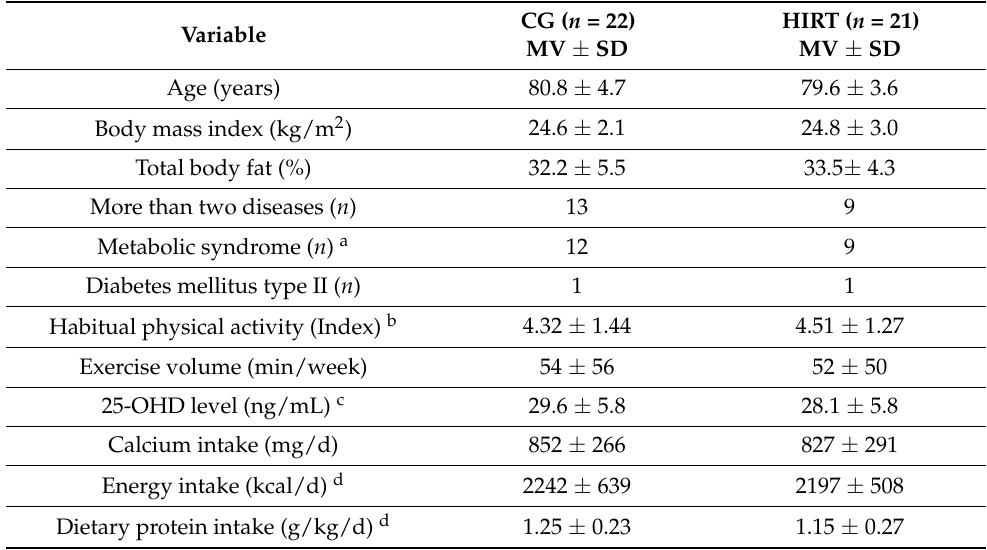
Table 1. Baseline characteristics (i.e., before detraining) of the participants of the exercise and control group. CG: control group; EG: exercise